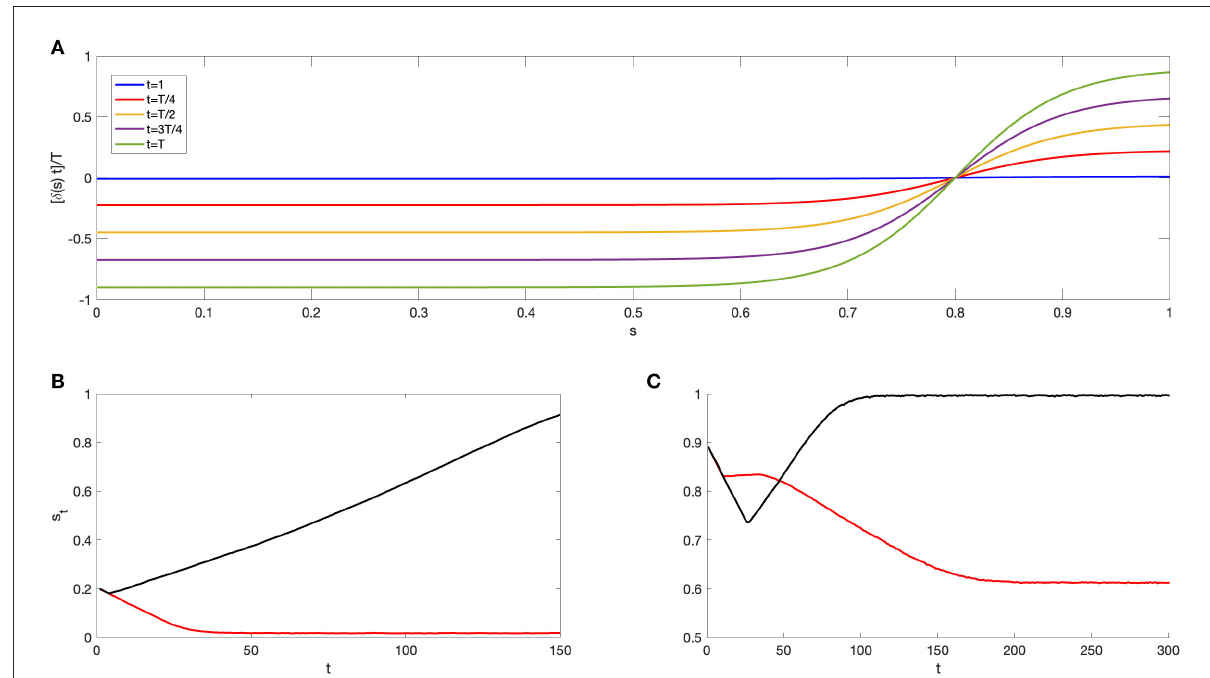
FIGURE7 defined as a function of the state s t for different specific values of time: t = Analytical individual with emotions. (A) reports the new term δ ( s ) t T { t 0 , T/4 , T/2 , 3T/4 , T} . (B, C) analyze the effect of emotions on an individual with p r = 0.8, starting with a low (s 0 = 0.2) and a high ( s 0 = 0.9) initial state, respectively. The red line indicates the behavior in presence of emotion whereas the black line in absence of emotion (considering